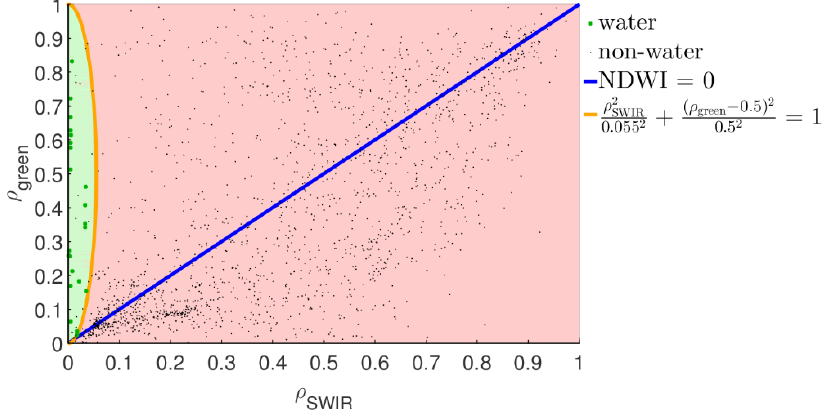
Figure 5. Non-linear decision boundary for all the water and non-water spectra in the USGS spectral library.